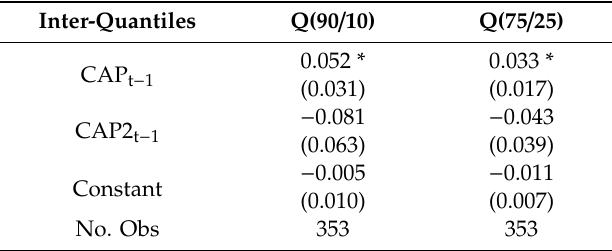
Table 10. The result for ROA: inter-quantile regression.